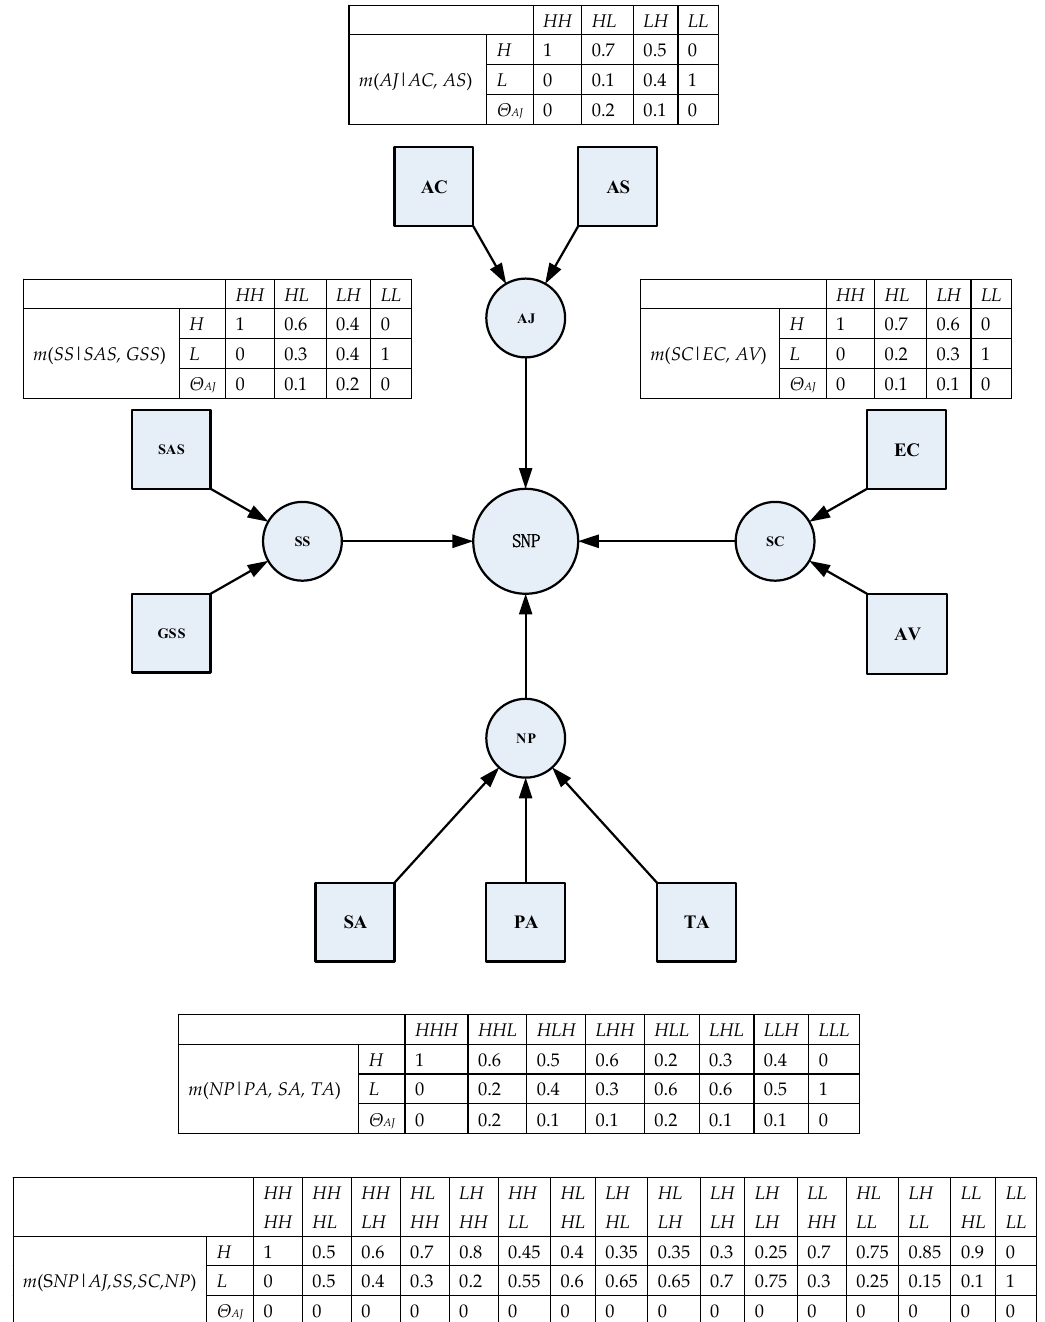
Figure 2. Conditional-belief-parameter table for spatial navigation and positioning capabilities.